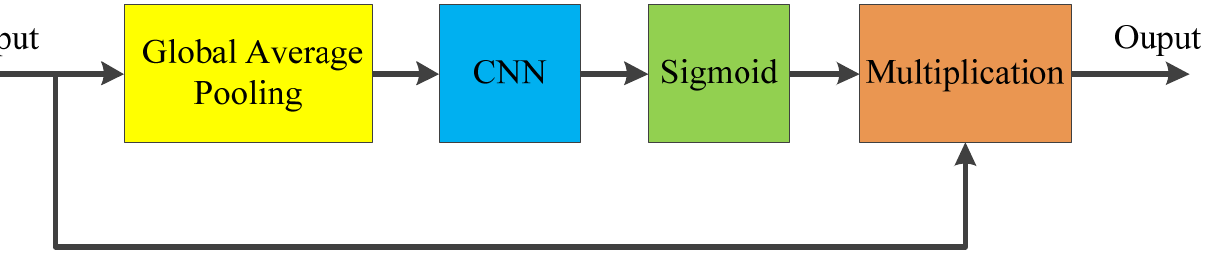
Figure 2. The overview of the ECA module.